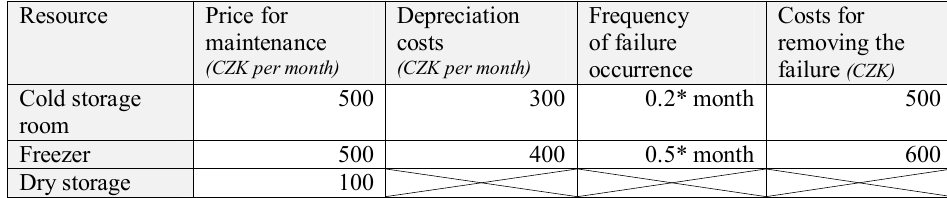
maintenance (CZK per month)